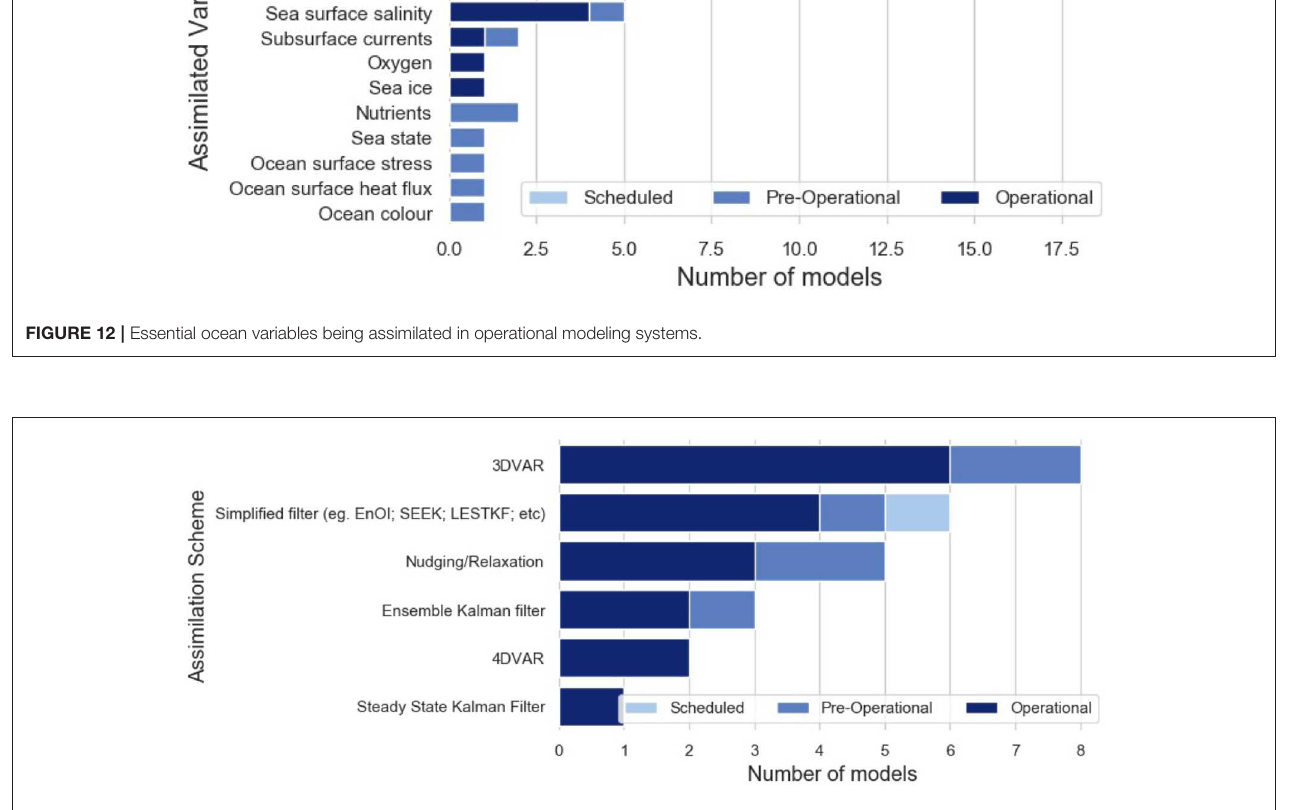
FIGURE 13 | Proportion of assimilation schemes being used in operational modeling systems.